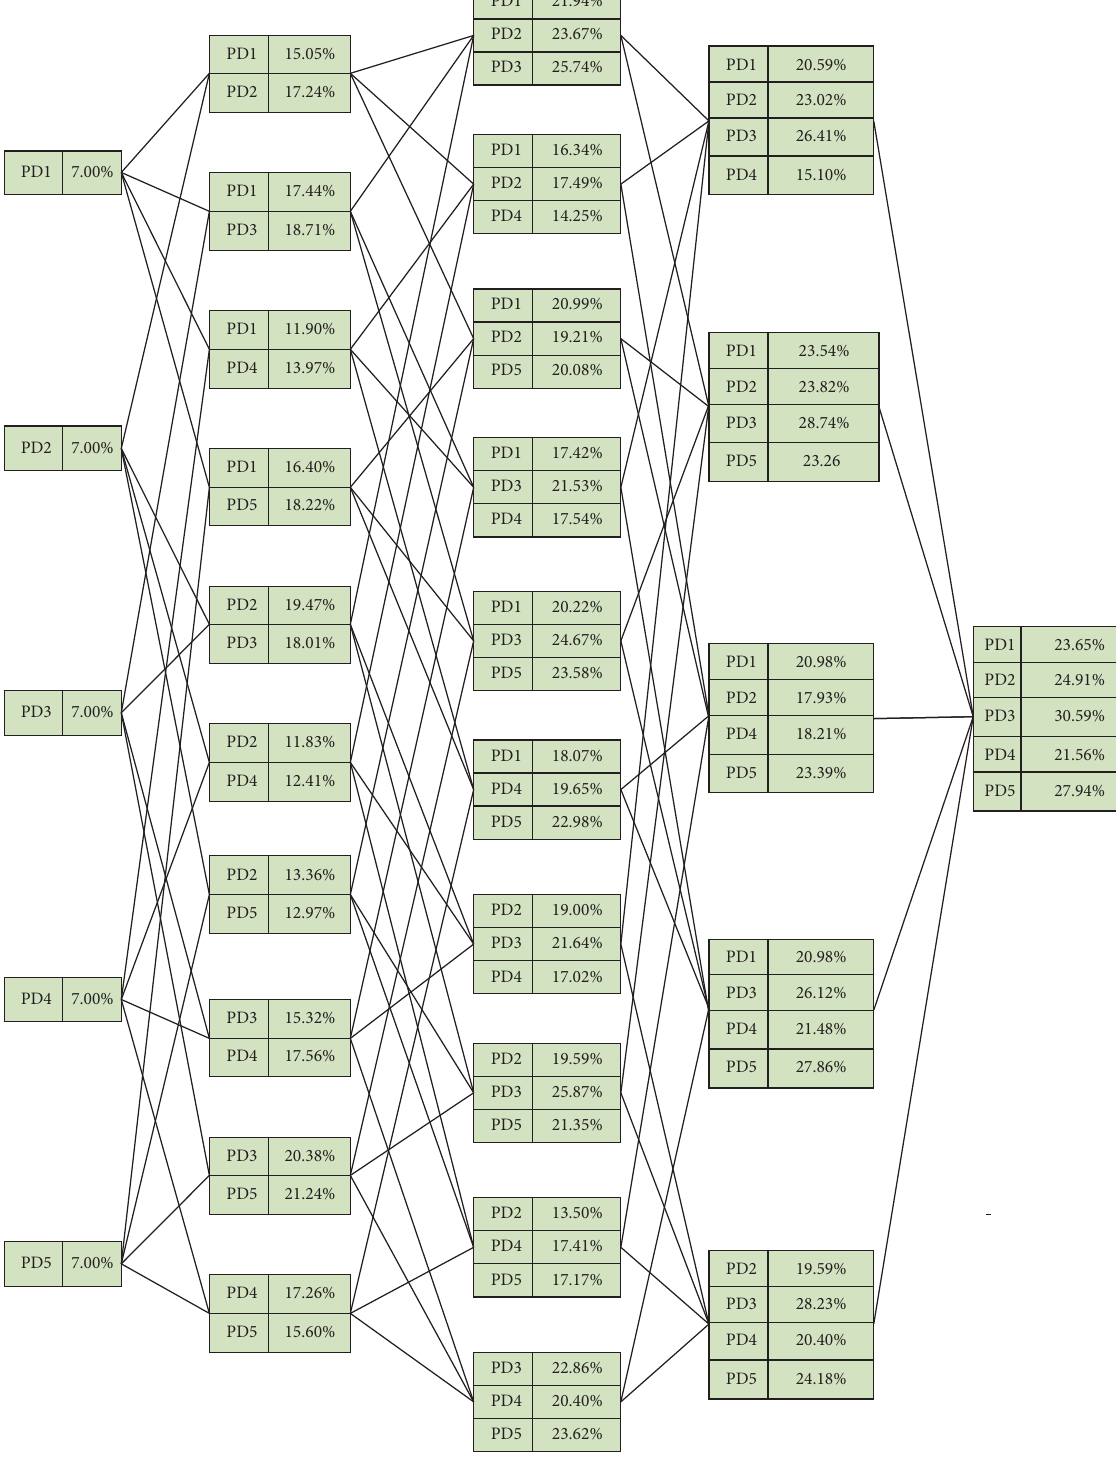
Figure 7: Cost reduction percentages and grand alliance formation